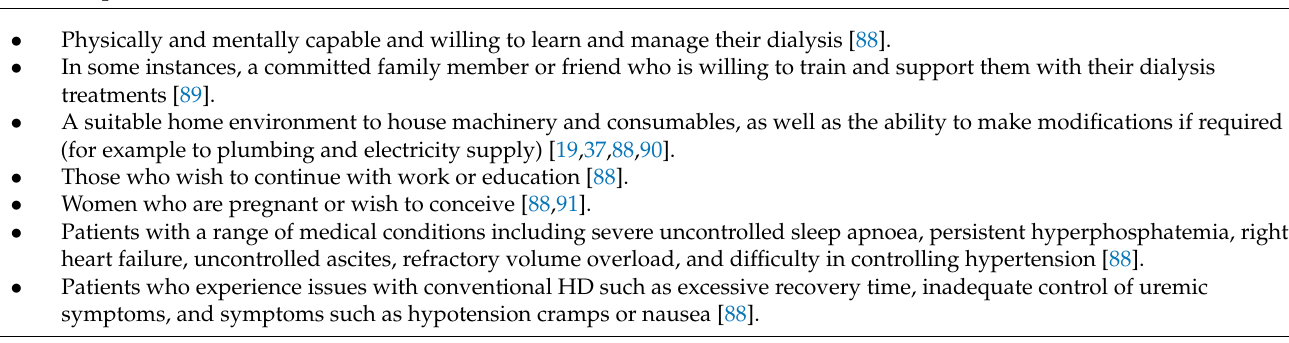
Table 2. Selected patient eligibility criteria for